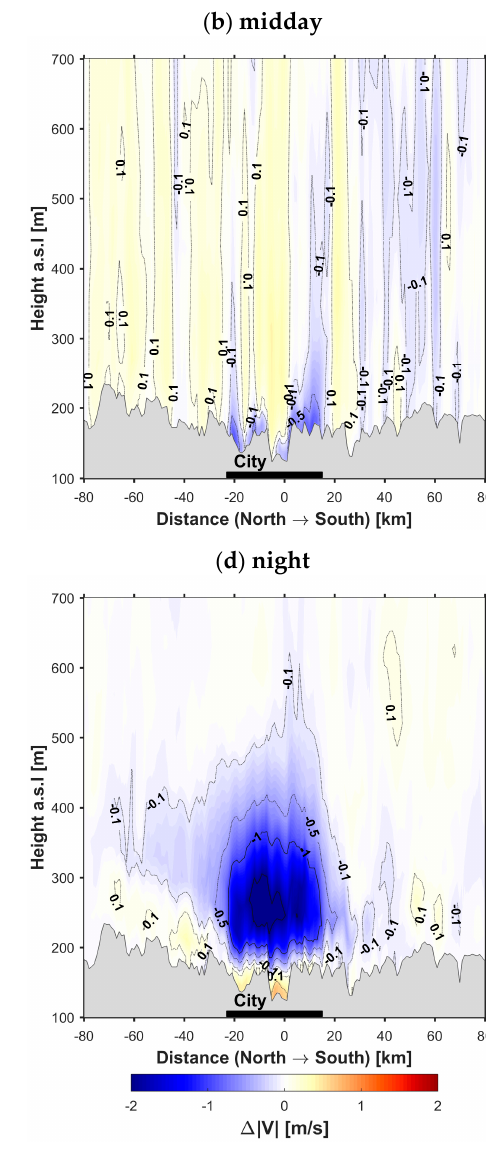
Figure 9. Vertical meridional cross-sections through the center of Moscow in the field of the modeled wind speed response to switching on the urban canopy model ( ∆ | V | ): daily-mean ( a ); mean daytime (13 UTC/16 MSK) ( b ); evening (16 UTC/19 MSK) ( c ); and nocturnal (0 UTC/03 MSK) ( d ) values. Averaging is made for the days with intensive urban heat island during June–August 2014. Designations are similar to Figure 4.